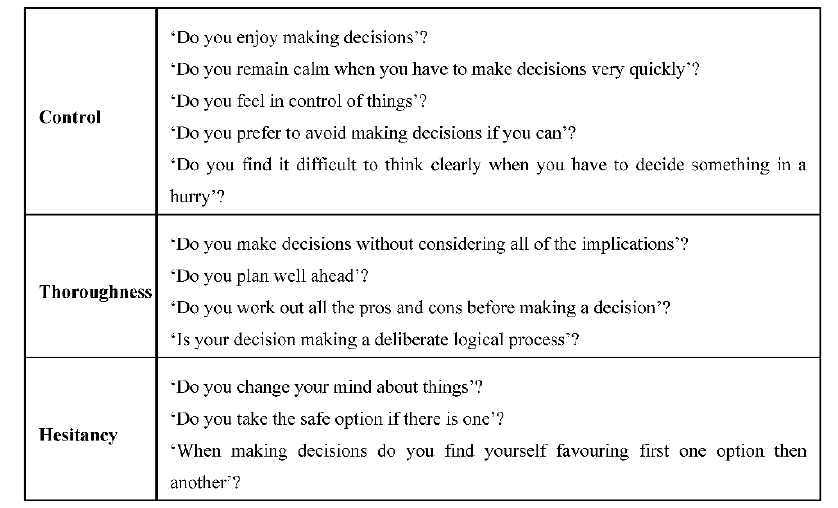
Figure 6. Decision-Making Questionnaire (DMQ) questions (Total of 12 questions) (Source: Own creation).